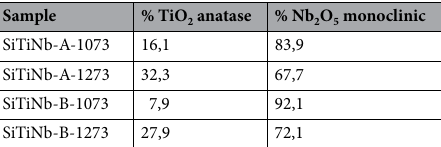
Table 3. Percentage between the crystalline phases in the calcined SiTiNb samples.